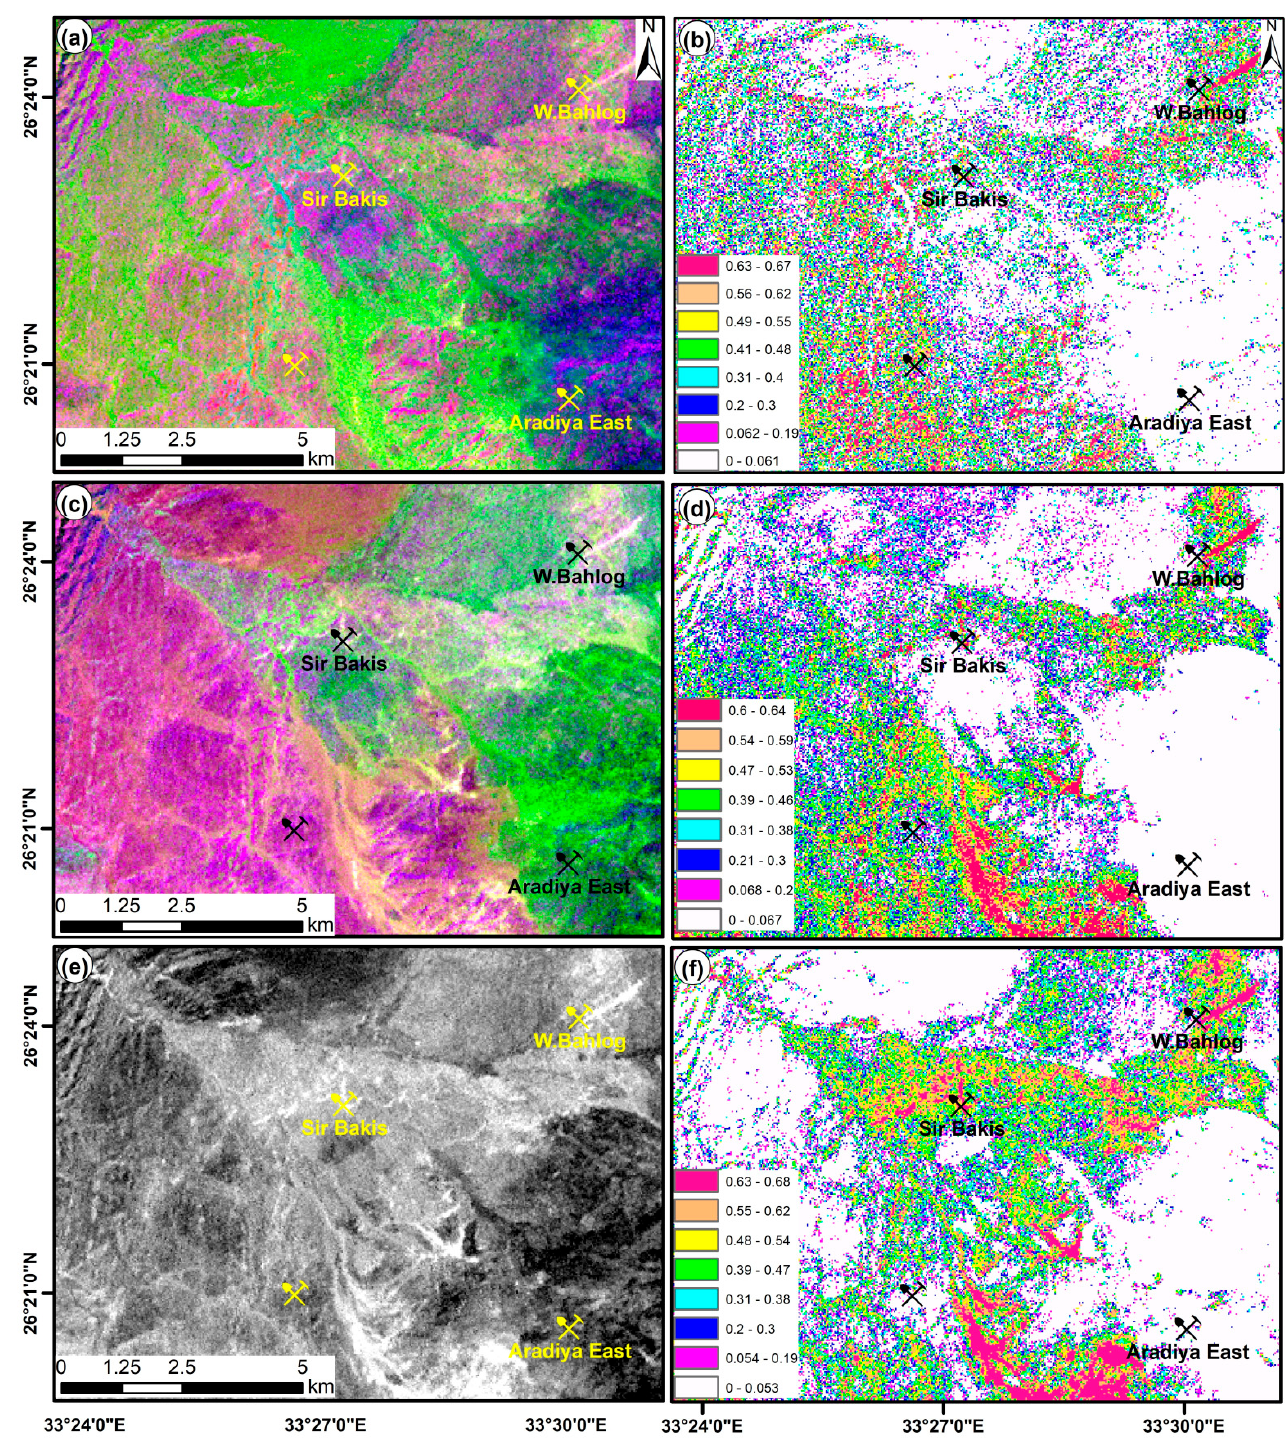
Figure 6. ASTER ( a ) ASTER band ratios 5 + 7/6 (argillic-phyllic), (4 + 6)/5 (advanced argillic), and (5 + 8)/(6 + 7), (hydrous silica) in R, G, and B; ( b ) reclassification of a; ( c ) OHI, 4/7, and (5 + 7)/6; ( d ) reclassification of c; ( e ) PC2 of ASTER bands 4, 5, and 6; ( f ) reclassification of “e”.